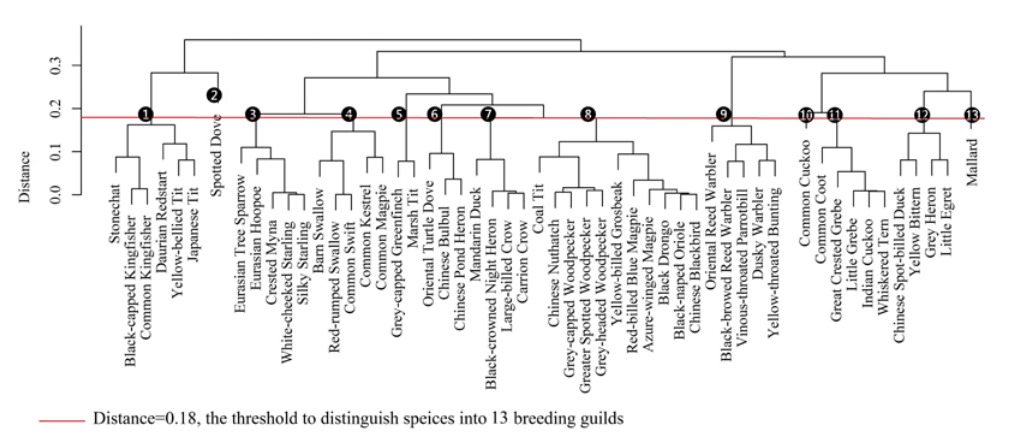
Figure 3. Trait dendrogram for breeding guilds. Notes: The length of the branches in the vertical direction indicates the dissimilarity from other species. At the bottom of the dendrogram is the species name. The red horizontal line indicates the threshold 0.18 to distinguish breeding guilds. The